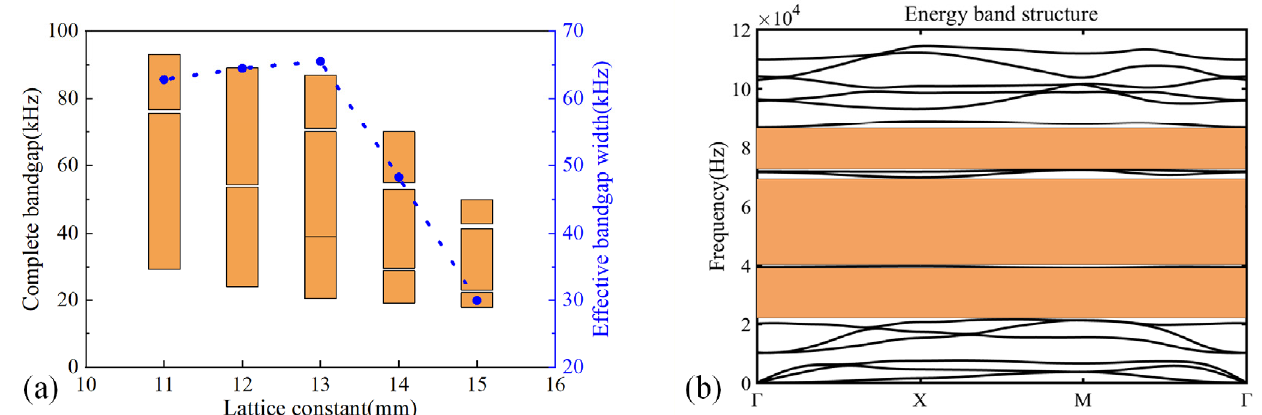
Figure 7. ( a ) Bandgap characteristics of the unit cell with different lattice constants when h 1 = 1 mm, h 2 = 4 mm, and b 1 = 0.77a. ( b ) The energy band structure for the 13 mm unit cell. The parameters used are as follows: a = 13 mm, h 1 = 1 mm, h 2 = 4 mm, b 1 = 10 mm, L 1 = 6 mm, L 2 = 4.4 mm, b 2 = 1.2 mm.